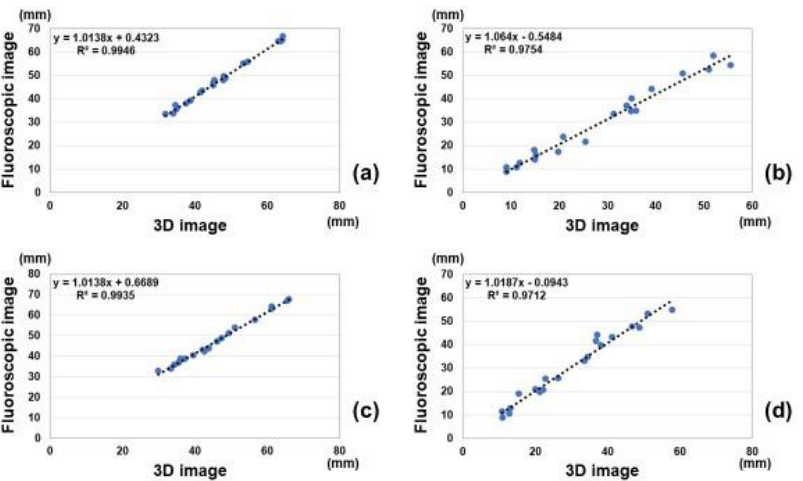
Figure 4. Correlations of marker distances between measurements on the fluoroscopic image and estimated 3D image. ( a ) Anterior-posterior view, ( b ) Ulnar side lateral view, ( c ) Posterior- anterior view, and ( d ) Radial side lateral view.